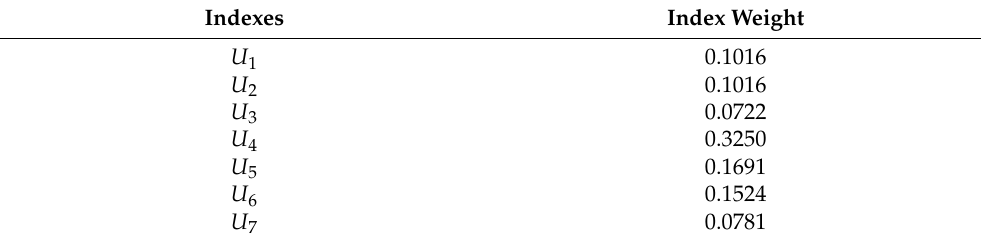
Table 16. Total weight of indexes.